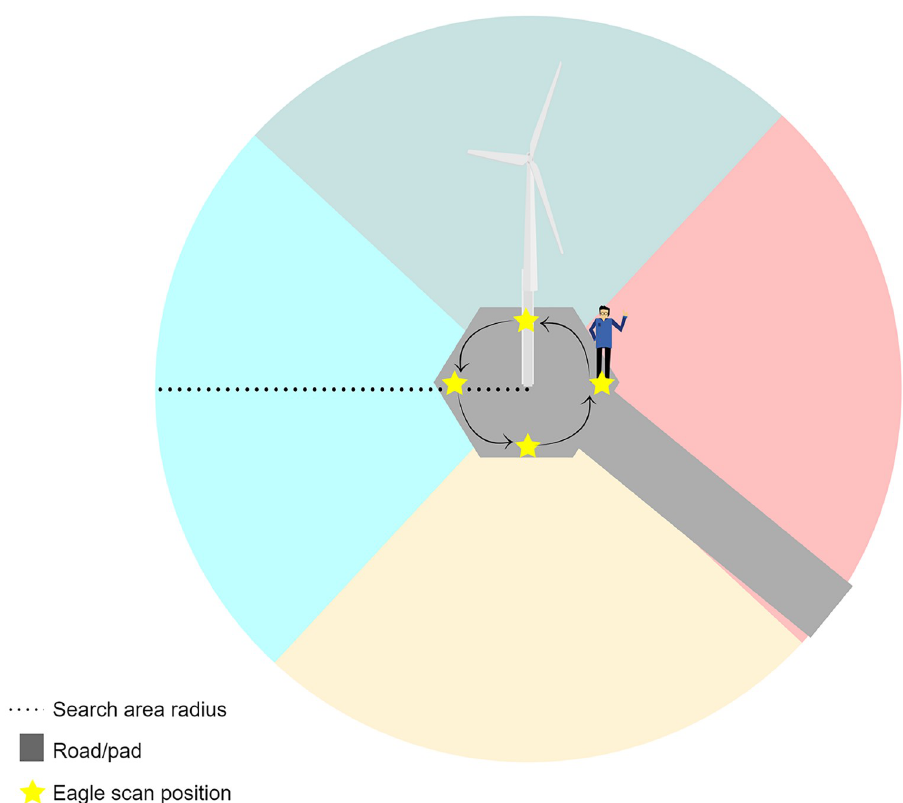
Fig 2. Diagram of eagle scan positions around a turbine (not to scale).